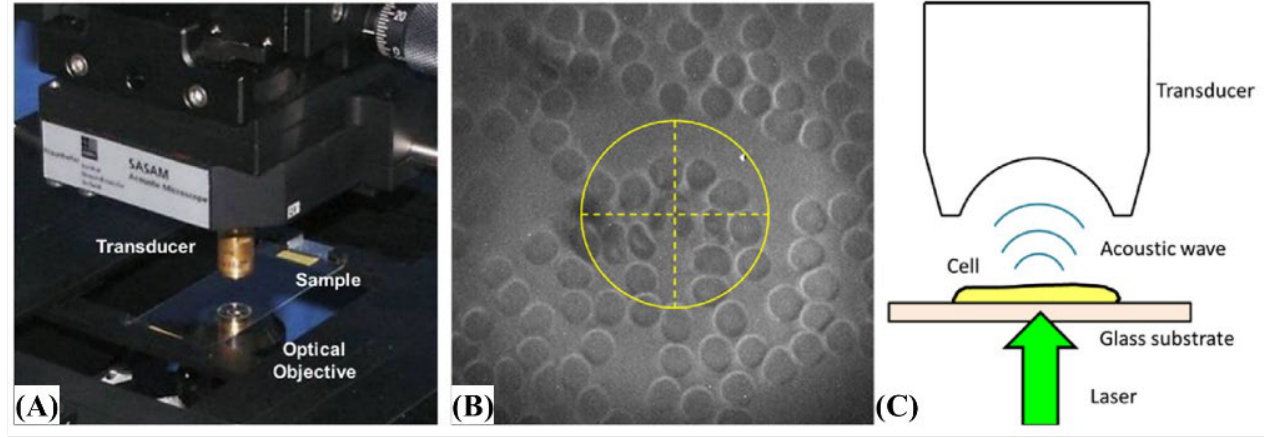
Figure 18. ( A ) Acoustic microscope. ( B ) An optical view of a stained blood smear with the